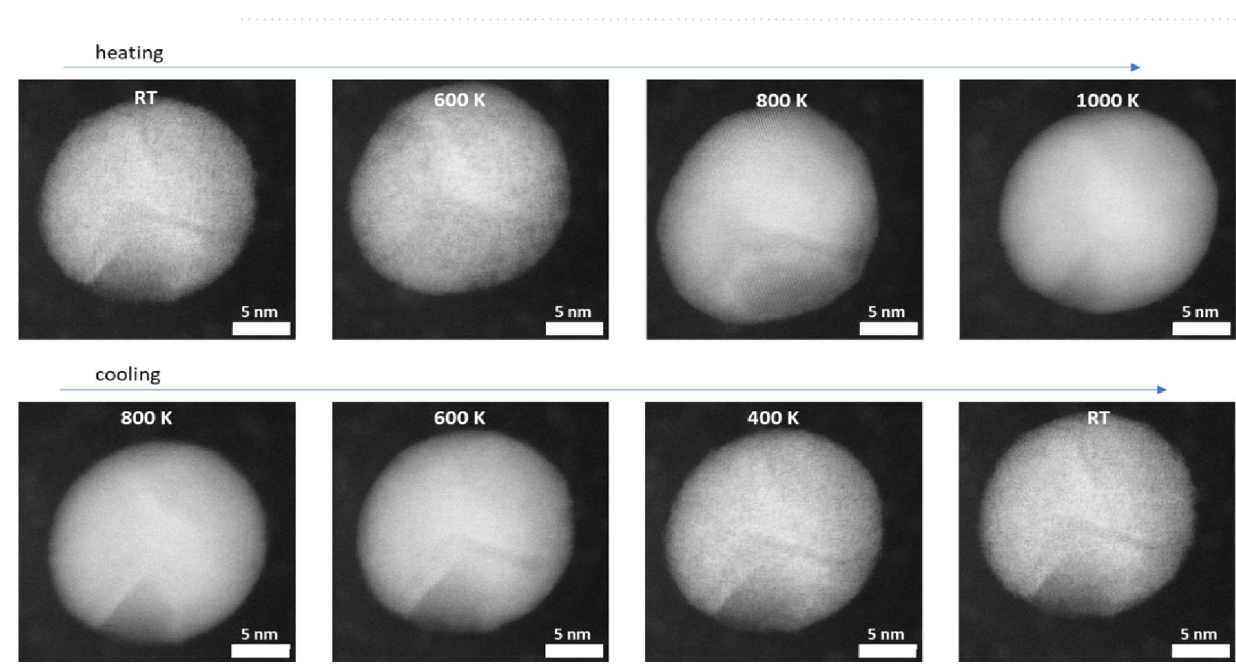
Figure 6. Dark-field TEM images of a selected FeRh nanoparticle evolution for different in-situ annealing